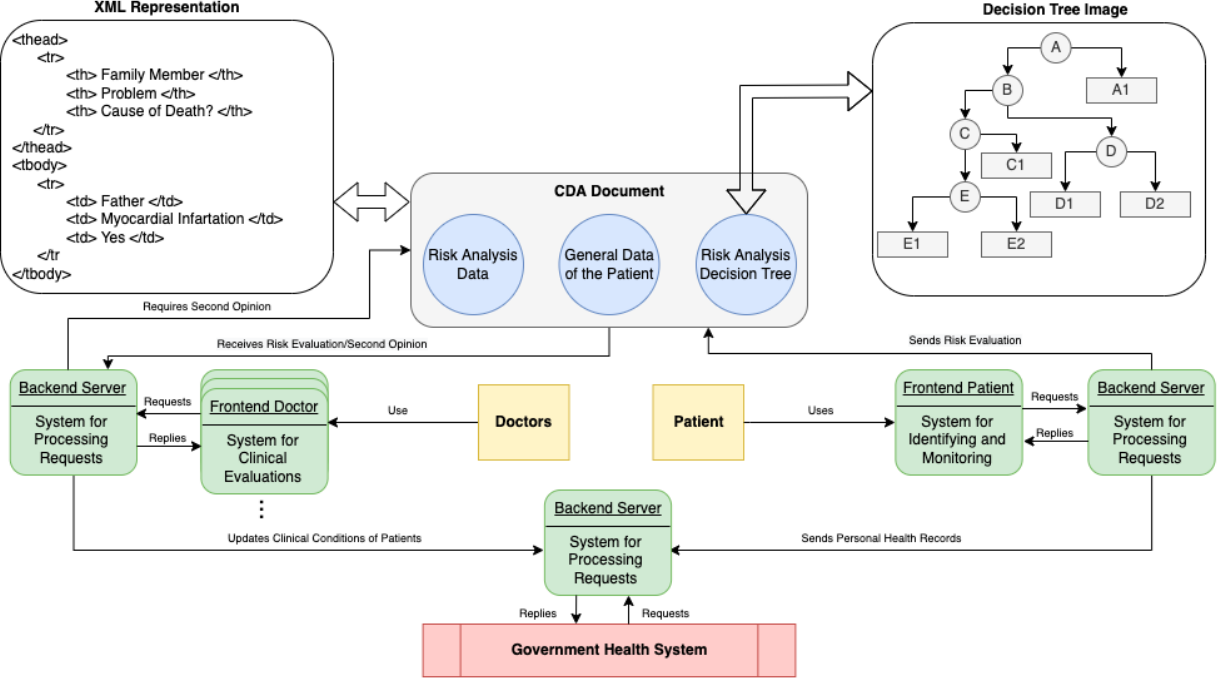
Figure 5. DSS methodology schema of identification and monitoring of CKD in developing